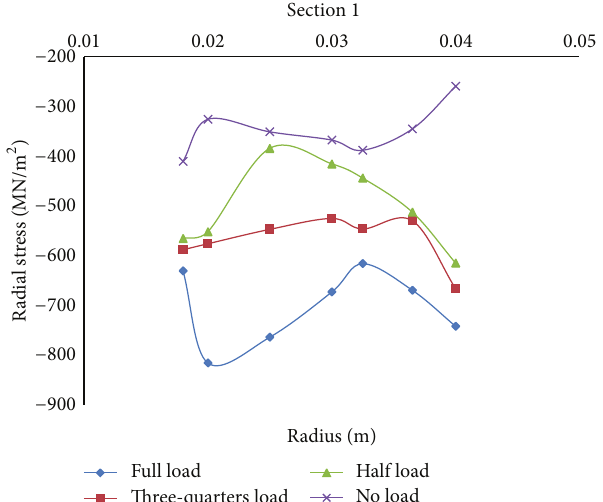
Figure 17: Piston distortion at full